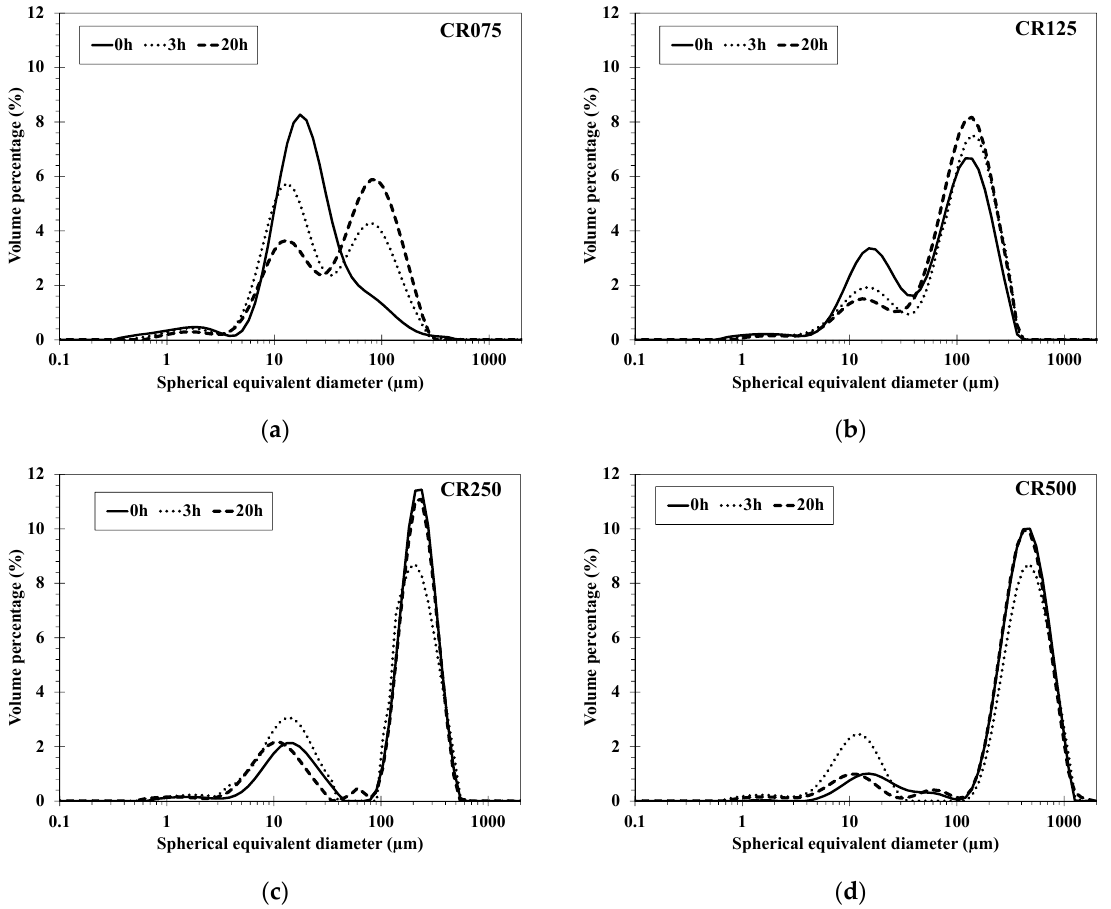
Figure 6. Evolution of particle size distribution during hydrolysis of ( a ) CR075, ( b ) CR125, ( c ) CR250 and ( d ) CR500 suspensions (CR075, CR125, CR250 and CR500 are cassava flour with the particle sizes of under 75 µm, 75–125 µm, 125–250 µm and 250–500 µm, respectively).